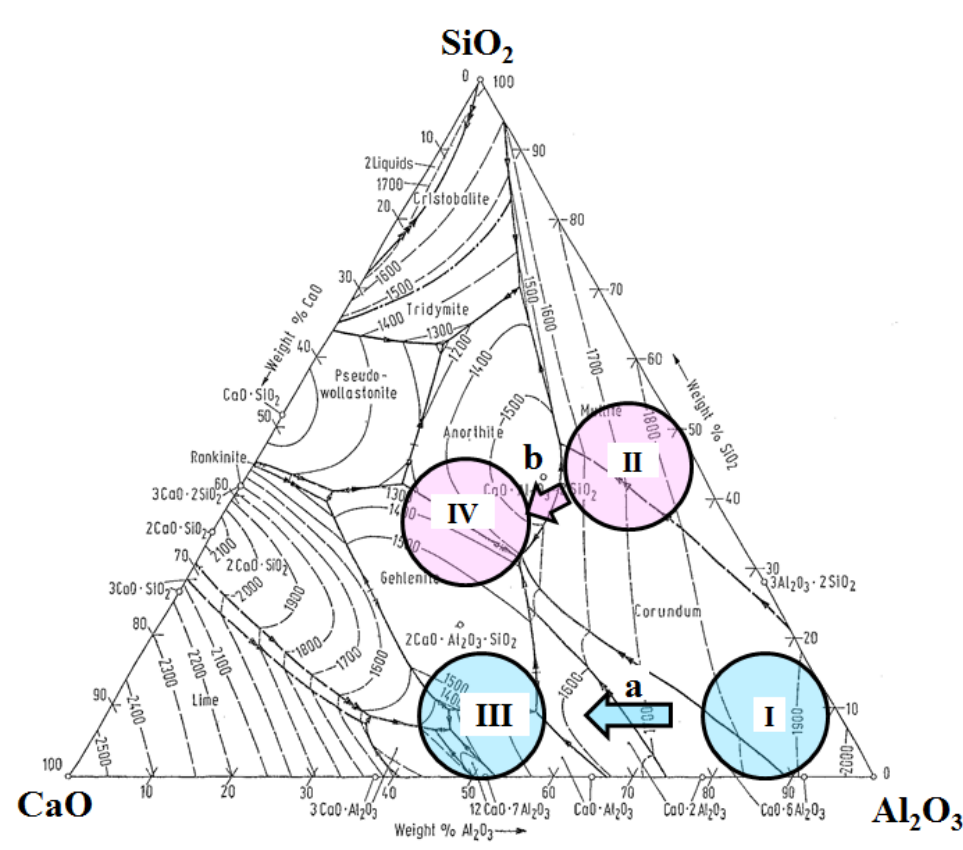
Figure 21. Compositions of different oxide inclusions precipitated in aluminum ( a ) and silicon ( b ) deoxidized steel grades [68].